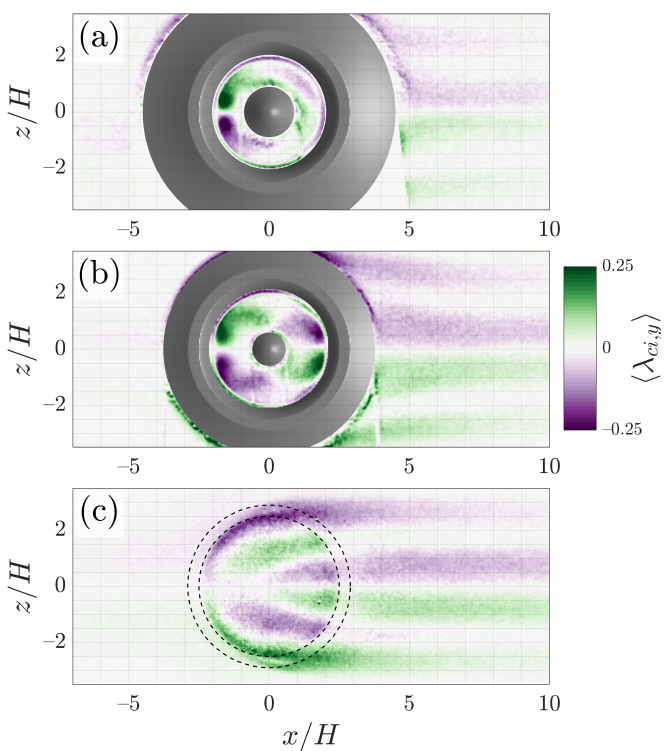
Figure 15. Mean swirling strength (cid:104) λ ci , y (cid:105) in the wall-parallel measurement planes located at ( a ) y / H = 0.3, ( b ) y / H = 0.6, and ( c ) y / H = 1.1. Re H = 8.9 × 10 3